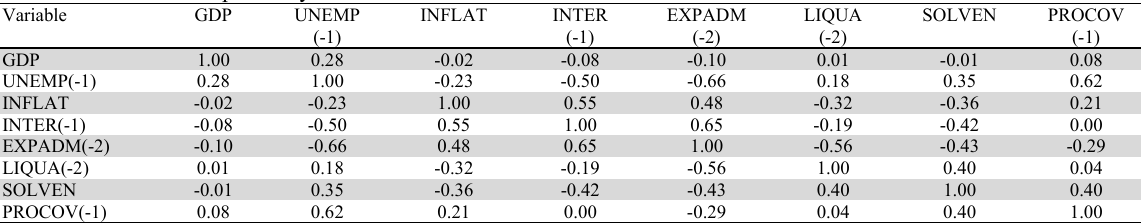
Correlation matrix of explanatory variables